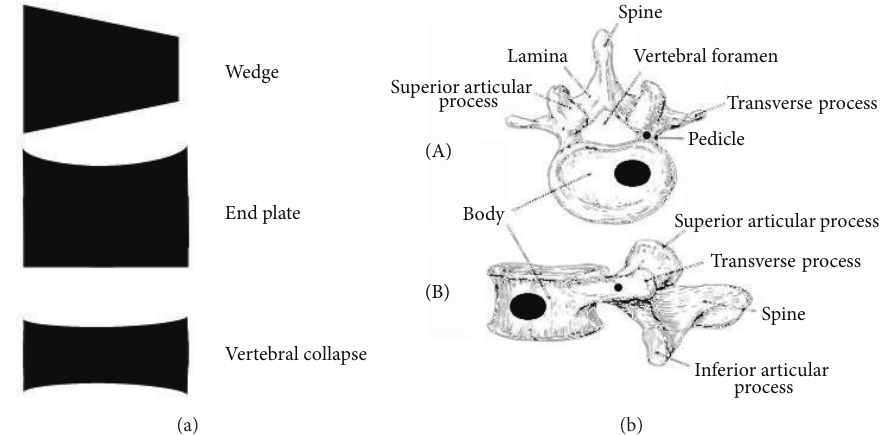
Figure 1: Shape of vertebral fractures (a) and localization of osteolyses within the vertebral body